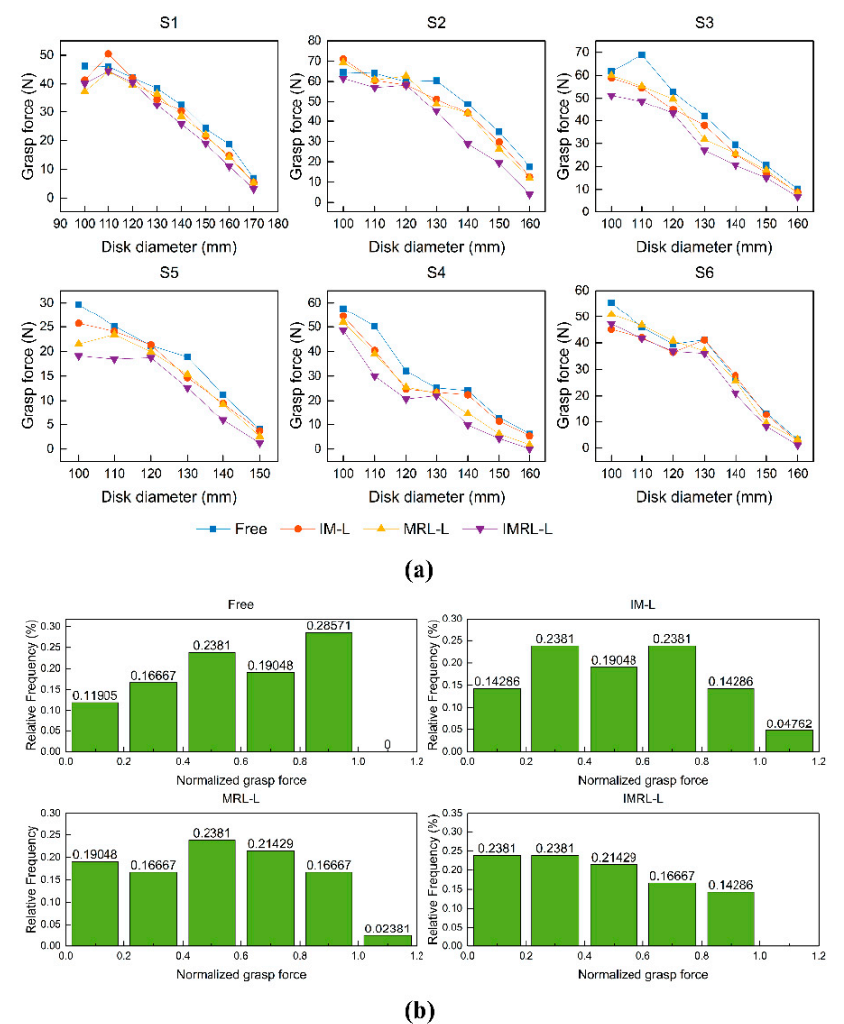
Figure 7. Results of the grasp force experiments. ( a ) Grasp force of 6 subjects, ( b ) frequency distribution histograms of normal grasp force under 4